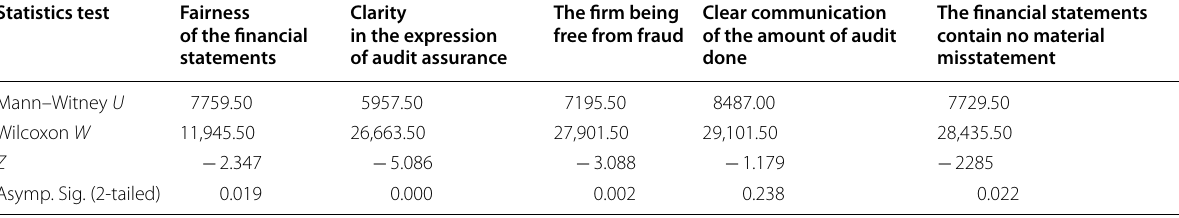
Table 4 Reliability statement statistics test. Source: Survey Data Analysis (2019) Statistics test